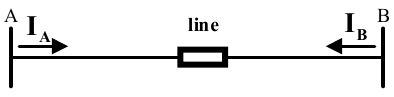
Figure 1. Doubly-fed line.